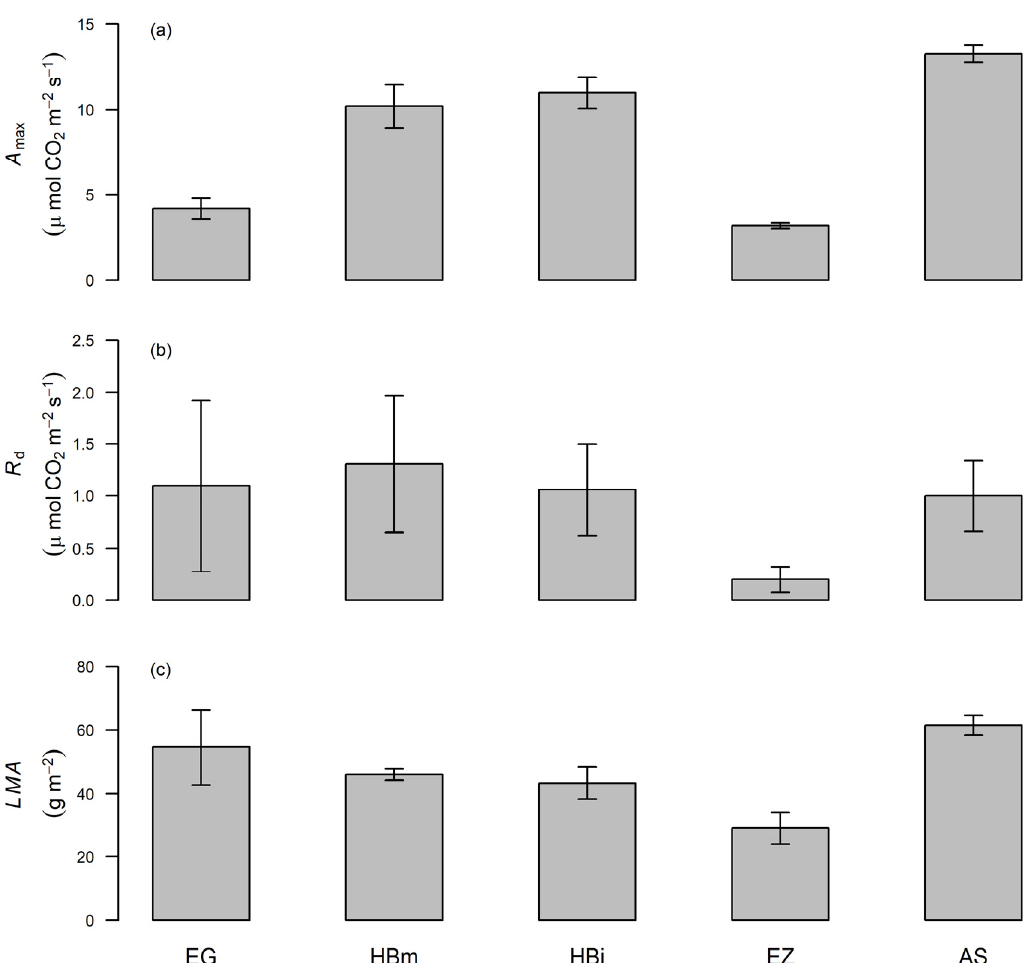
Figure 2. Mean (with standard error bars, n = 4) light-saturated net photosynthesis ( A max , ( a )), non-photorespiratory respiration ( R d , ( b )) and leaf mass per area ratio ( LMA ) ( c ) of leaves of monoculture oil palm (EG), monoculture rubber tree (HBm), jungle rubber tree (HBj), and two native tree species (EZ and AS) measured at the lower part of the canopy. The data included matured oil palm and matured trees.